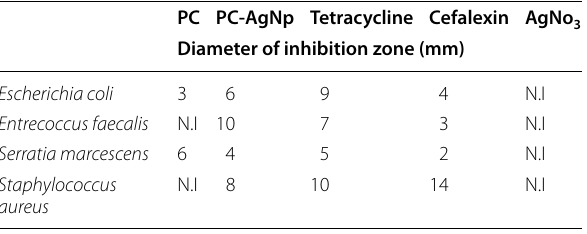
Table 1 Evaluation of PC and PC-AgNp antibacterial activity for Entercoccus faecalis , Staphylococcus aureus , Escherichia coli and Serratia marcescens based on inhibition zone diameter